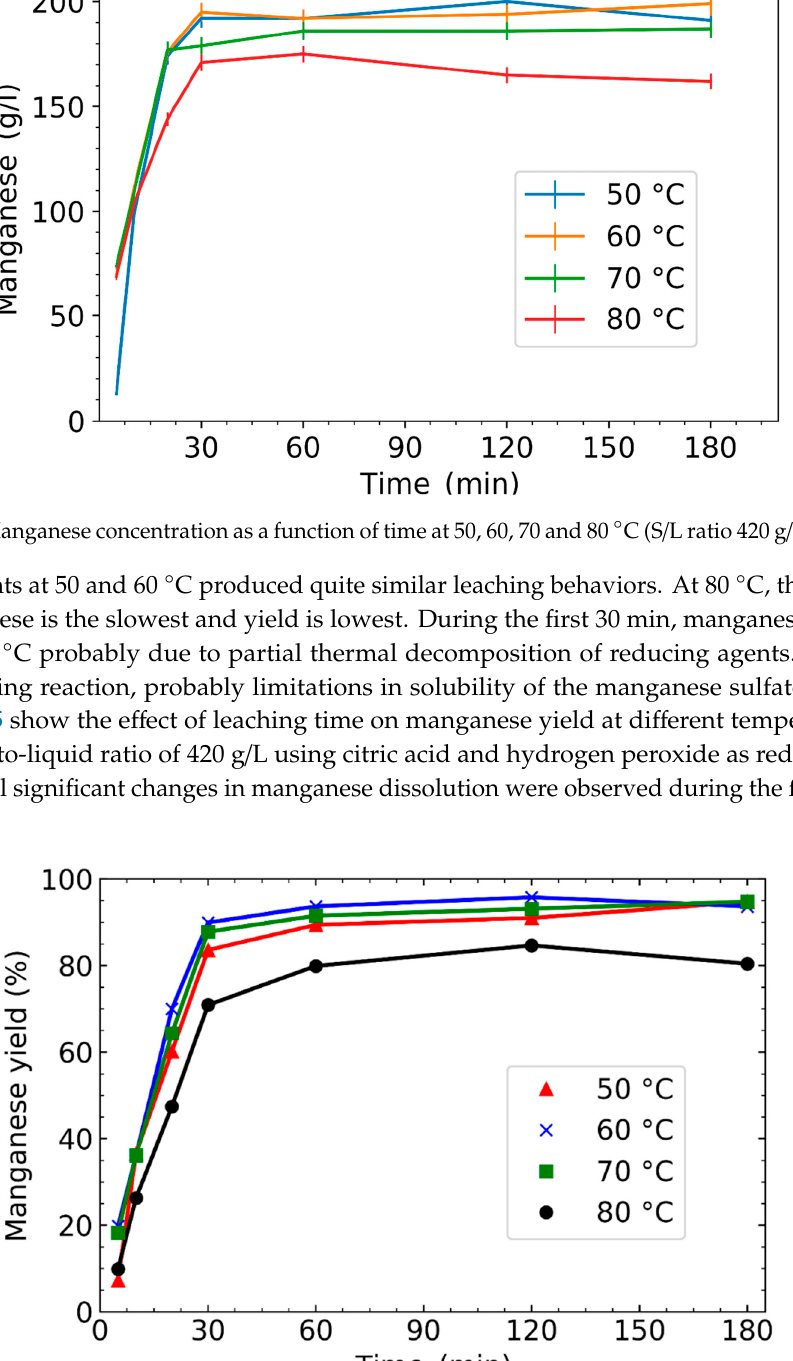
Figure 2. Manganese concentration as a function of time at 50, 60, 70 and 80 °C (solid-to-liquid (S/L) ratio 420 g/L, Citric acid).